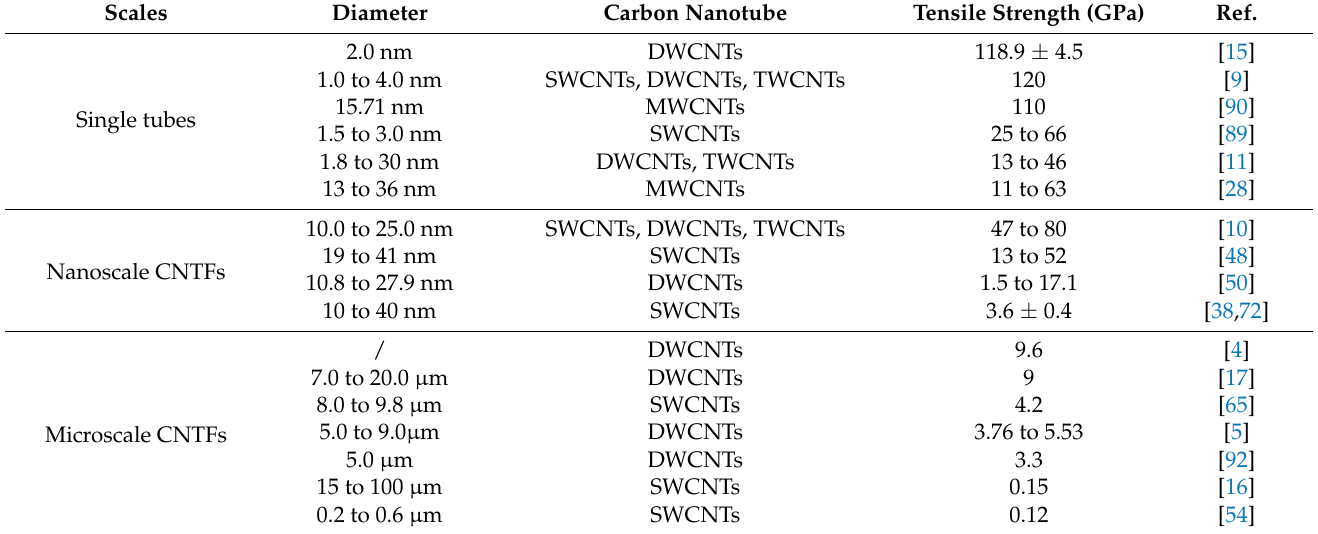
Table 1. Tensile strength of CNTs at different